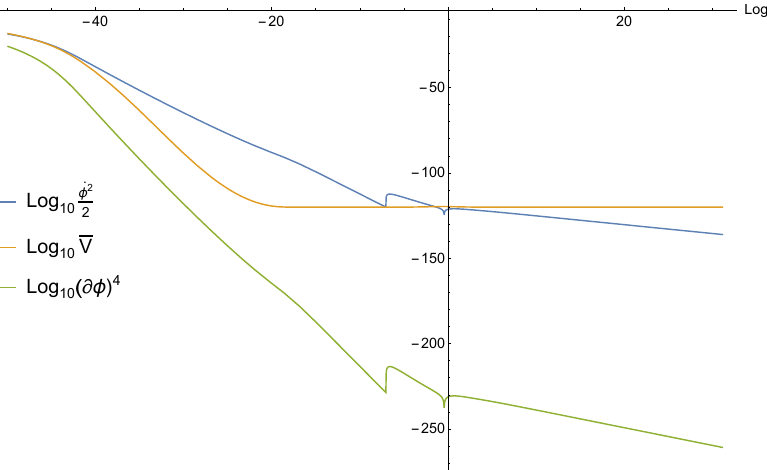
Figure 2. Log-log plot in Planck units of the contributions to the inflaton energy density as a function of the scale factor normalised to unity at present, starting at the end of inflation. The upper curve (blue) corresponds to the canonical kinetic energy density of the scalar field, which dominates the potential until the time of equal-matter-radiation densities (equality). At this time the field briefly freezes only to unfreeze in matter domination (because of the interaction with matter in Equation (21)) and again becomes dominated by its kinetic energy density until the present time when the potential energy density, depicted by the middle curve (orange), takes over. The quartic kinetic term in Equation (7), depicted by the lower curve (green), always remains